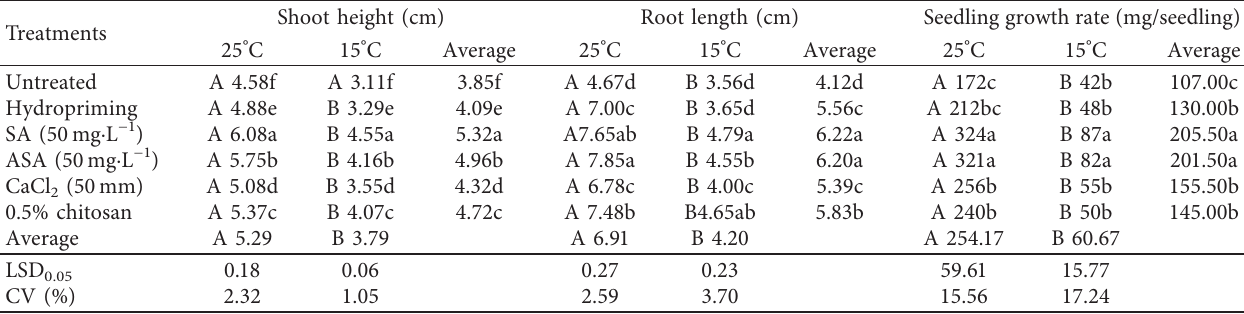
Table 2: Effects of seed priming on shoot height, root length, and seedling growth rate of Tainan 9 peanut seeds at 25 ° C and 15 ° C before 9 months of storage.